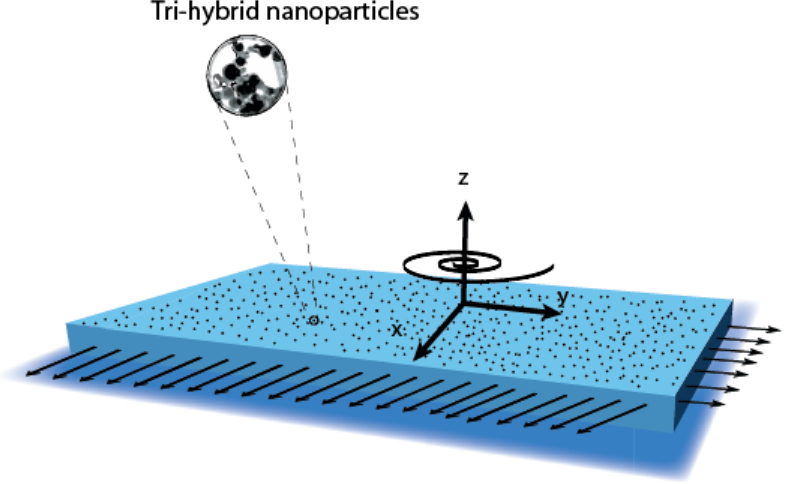
Figure 2. Coordinate system and physical illustration.